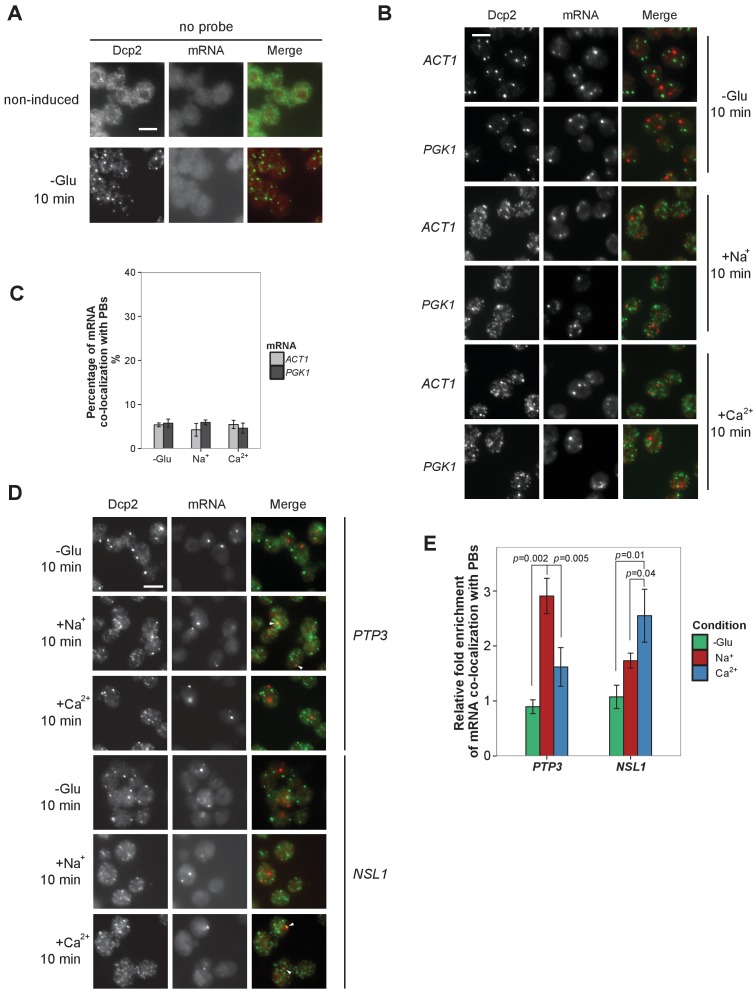
Evaluation of Na+, Ca2+ and non-candidate mRNAs by FISH-IF.(A) FISH-IF controls. Combined FISH-IF was performed without probes with cells expressing Dcp2-3HA under non-induced condition. Scale bar, 5 μm. (B) Fluorescence images of P-bodies and two non-candidate mRNAs, ACT1 and PGK1. Cells expressing Dcp2-3HA were treated with indicated stresses. Scale bar, 5 μm. (C) Bar plot depicting the percentage of co-localization between non-candidate mRNAs and P-bodies. The average of the percentages of ACT1 and PGK1 under each condition served as a control level in calculating the fold enrichment Figures pertaining to co-localization of mRNAs with P-bodies. Error bars, mean ±SEM. (D) Fluorescence images of P-bodies and Na+ (PTP3) and Ca2+ (NSL1)-specific candidate mRNAs under glucose depletion, Na+ or Ca2+ stresses. Scale bar, 5 μm. (E) Bar plot depicting the quantification of co-localization between candidate mRNAs and P-bodies following glucose depletion, Na+ or Ca2+ osmotic stresses. Error bars, mean ±SEM. A one-tailed, non-paired Student’s t-test was used to determine p values.10.7554/eLife.29815.009Figure 2—Figure Supplement 1—source data 1.Data used for plotting.Files contains data for panel C of Figure 2—figure supplement 1.
10.7554/eLife.29815.010Figure 2—Figure Supplement 1—source data 2.Data used for plotting.Files contains data for panel E of Figure 2—figure supplement 1.